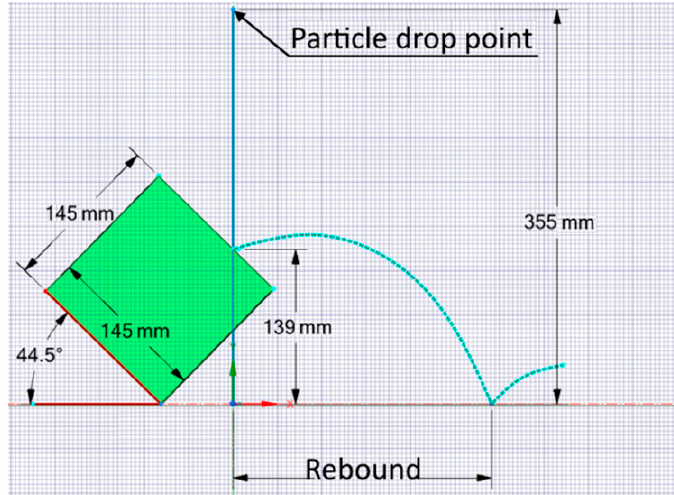
Figure 3. Restitution coefficient "ore-steel" experiment conditions.